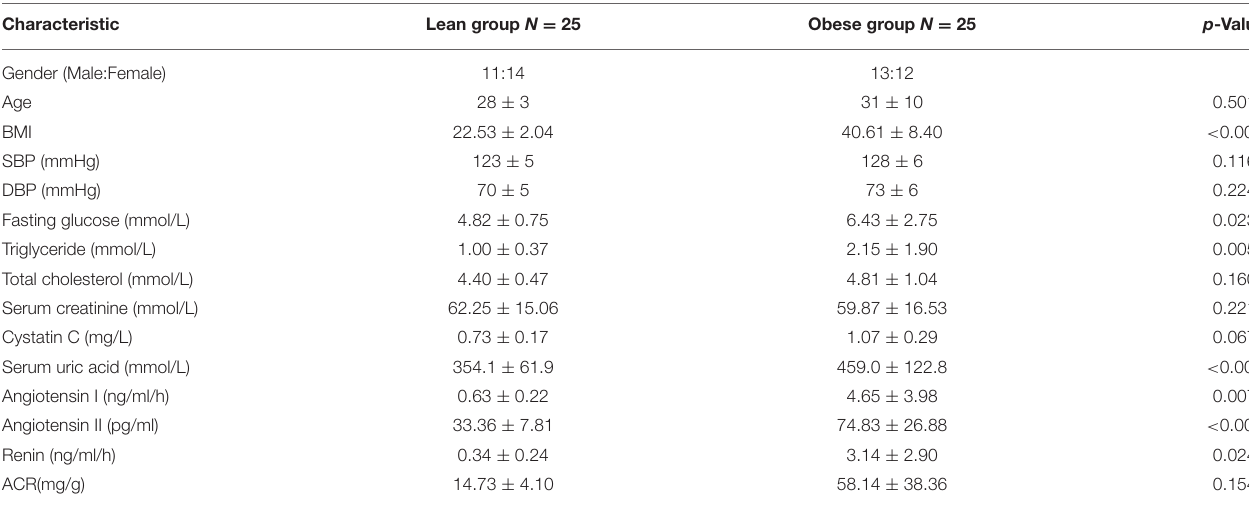
TABLE 2 | Baseline characteristics of study participants (mean ± SD).